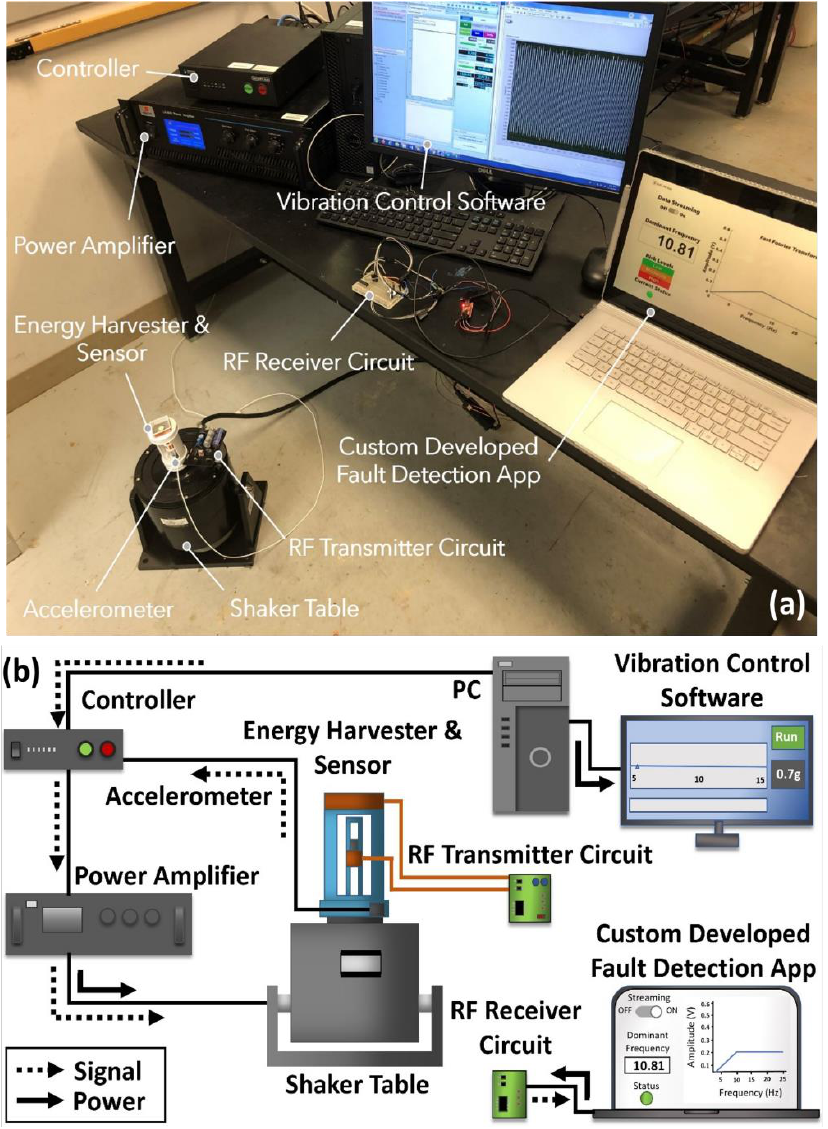
Figure 12. Experimental methods used in this work: ( a ) experimental apparatus used for characterization of the wireless self-powered vibration sensor system presented in this work; ( b ) cartoon schematic of the characterization setup showing signal and power flow in the equipment.